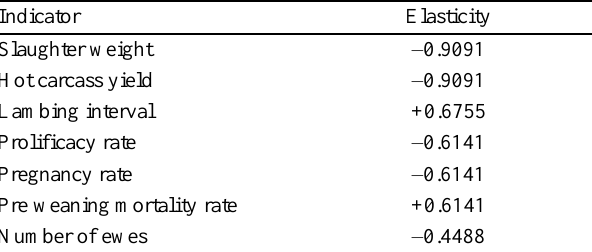
Table 6. Zootechnical indicator elasticity of the total cost for representative property of Sao Jose do Rio Preto: percentage change that would occur in the total cost of production upon a 1% increase in the zootechnical indicators Indicator